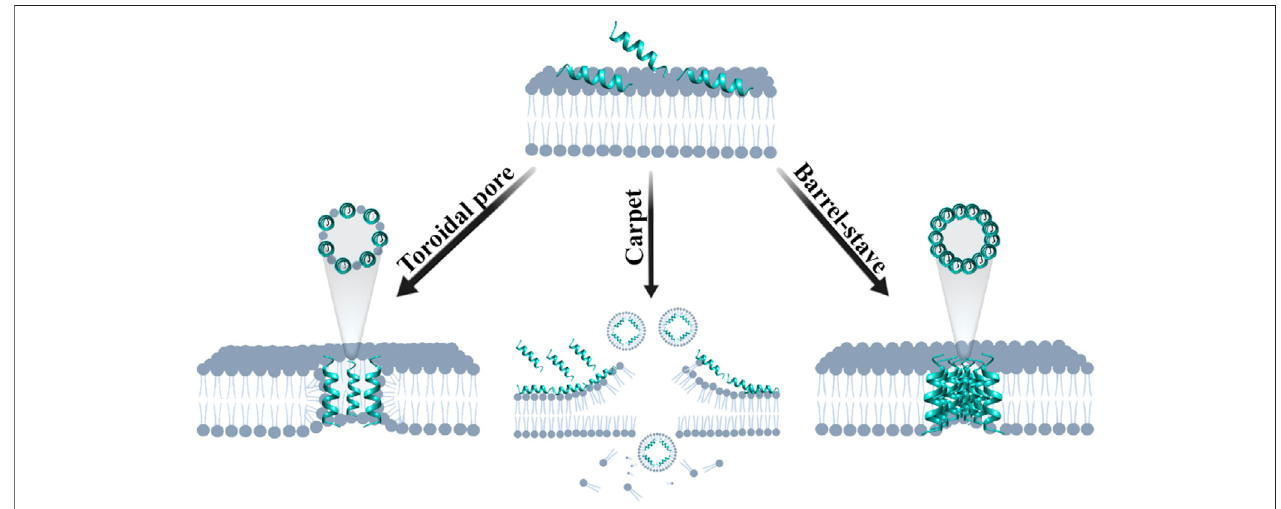
FIGURE 4 | Schematic models of the main proposed mechanisms of action of AMPs on microorganism cellular membranes.